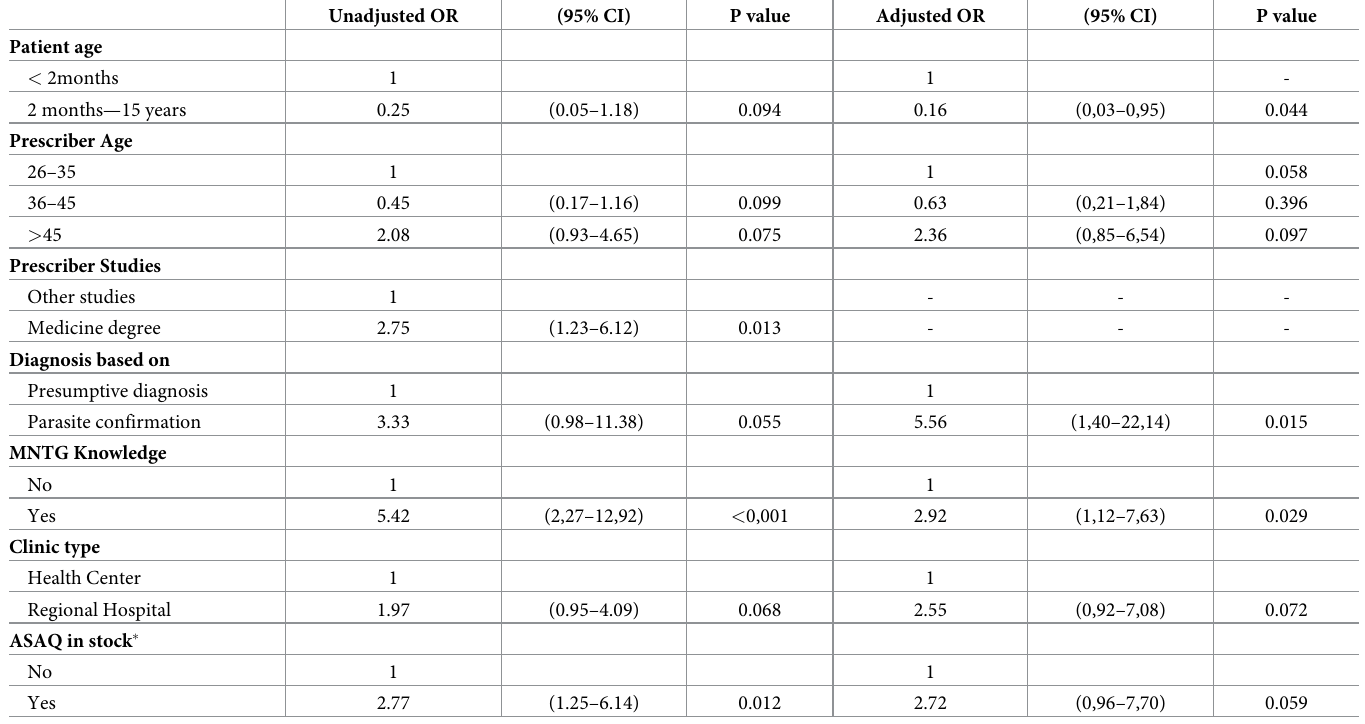
Table 6. Analysis of factors associated with recommended prescription according to